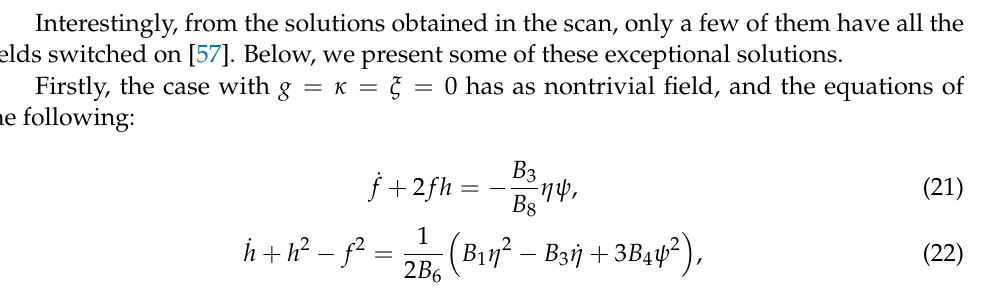
Figure 1. Decision tree depicting the scan of cosmological